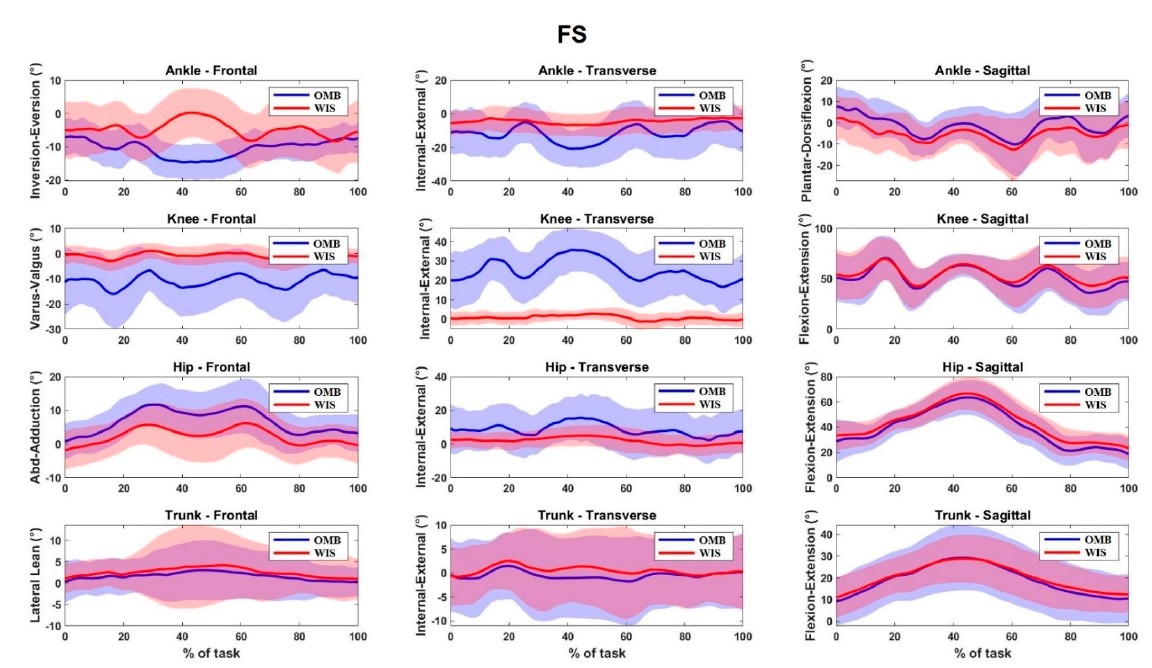
Figure A3. Joint kinematics of marker-based (OMB, blue) and inertial sensors (WIS, red) for the forward sprint (FS) task. Data are normalized by the length of the motor task. The waveforms are shown as average (solid lines) and standard deviations (shaded lines).